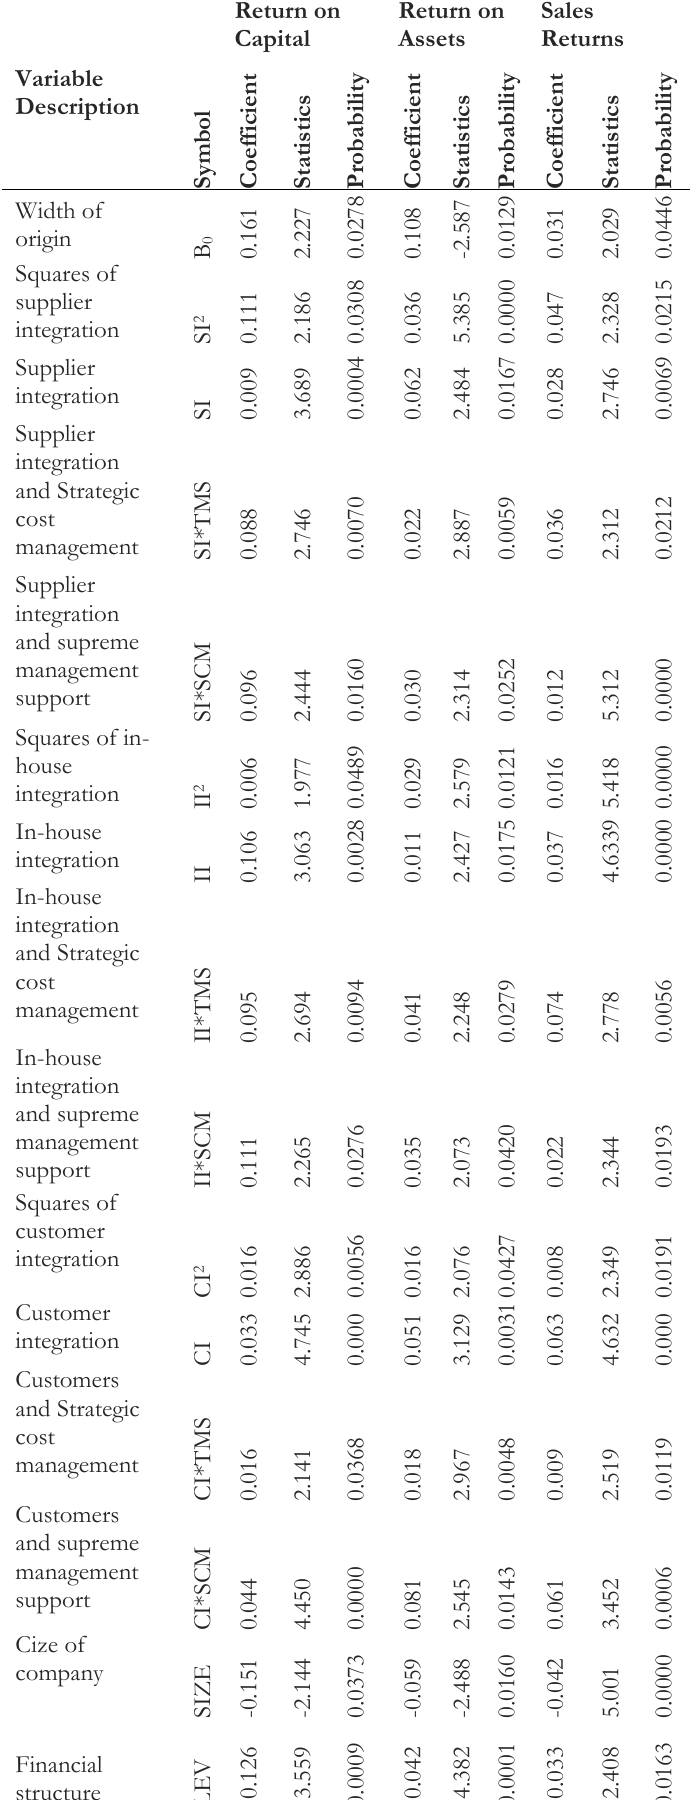
Table 3. The relationship between performance improvement and factors affecting